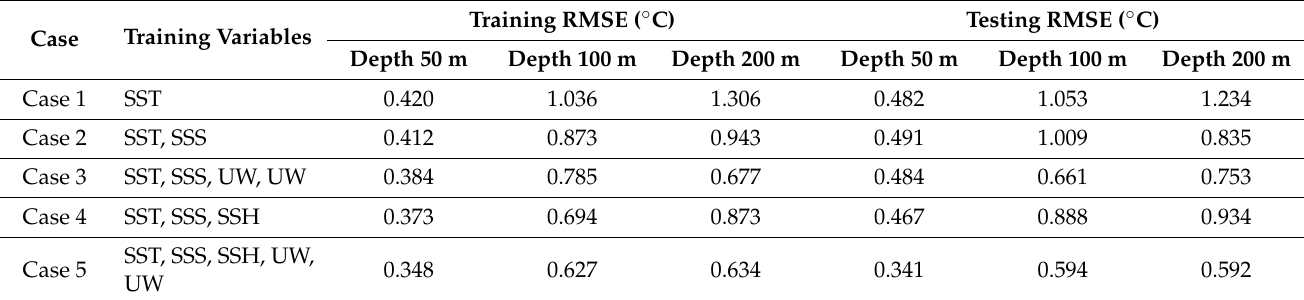
Table 4. Performance of the estimated OST vertical structure at 26 depths for each Case.